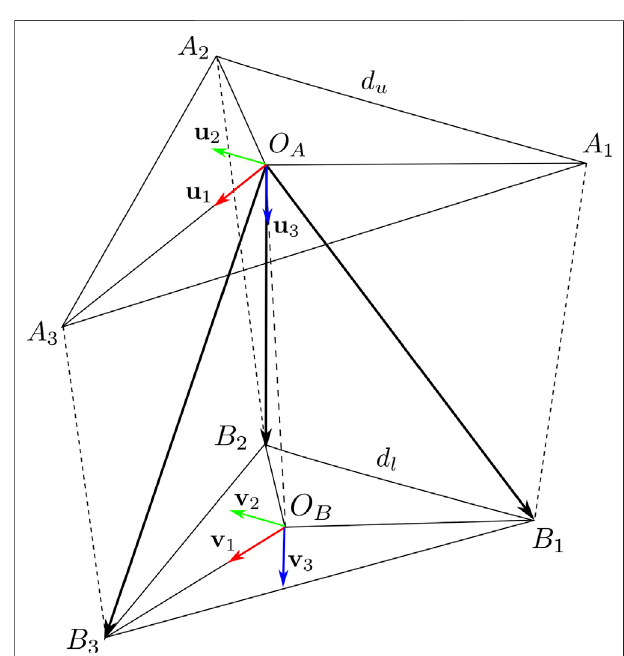
FIGURE 3 | Main points and coordinate frames for the analysis of the wearable haptic